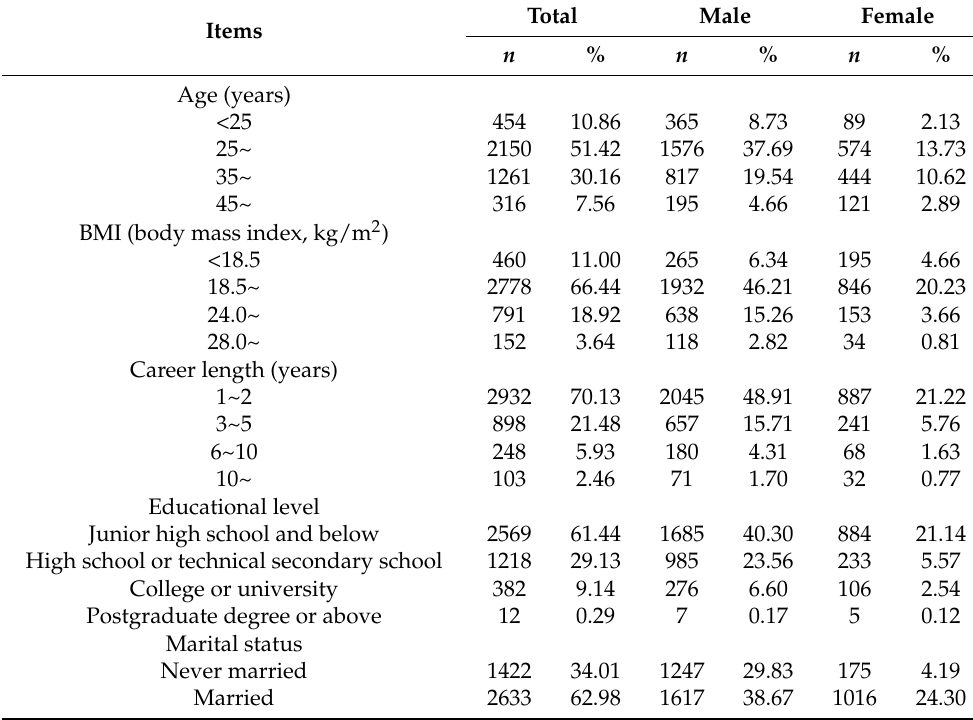
Table 1. Demographic and work-related characteristics of the participants (N =